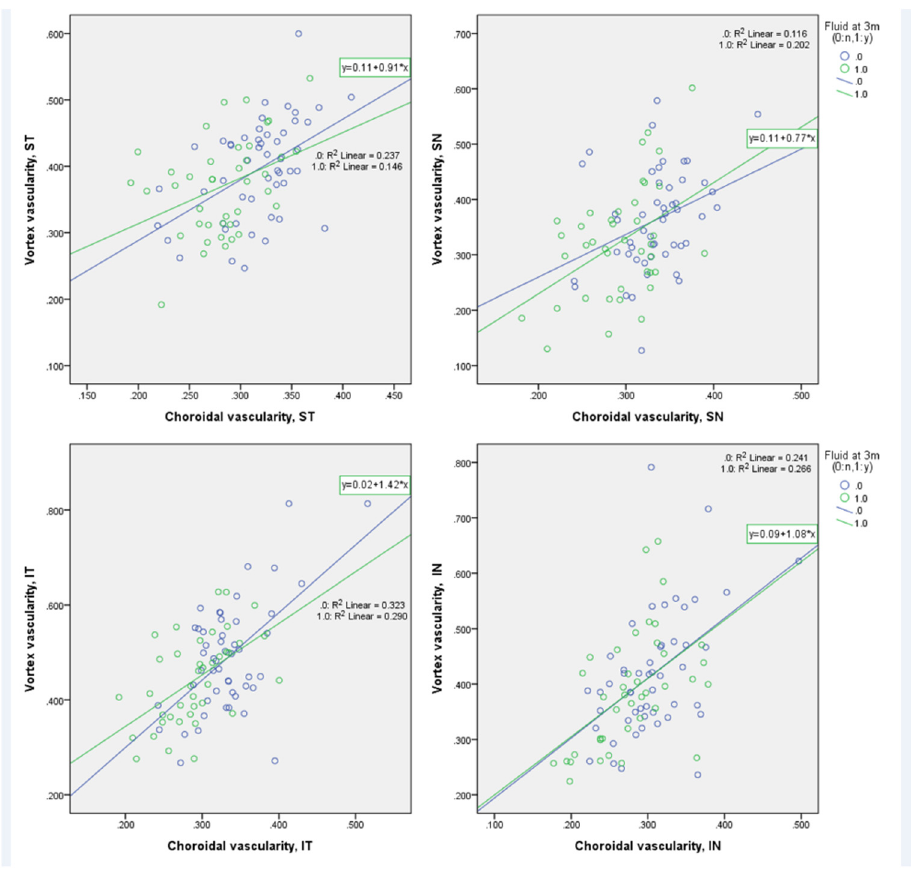
Figure 4. Correlation between choroidal vessel density (CVD) of each quadrant and vessel density around vortex ampullae of corresponding quadrants. In each quadrant, CVDs of vortex ampullae positively correlated with CVDs of the corresponding quadrants in both dry and non-dry groups.